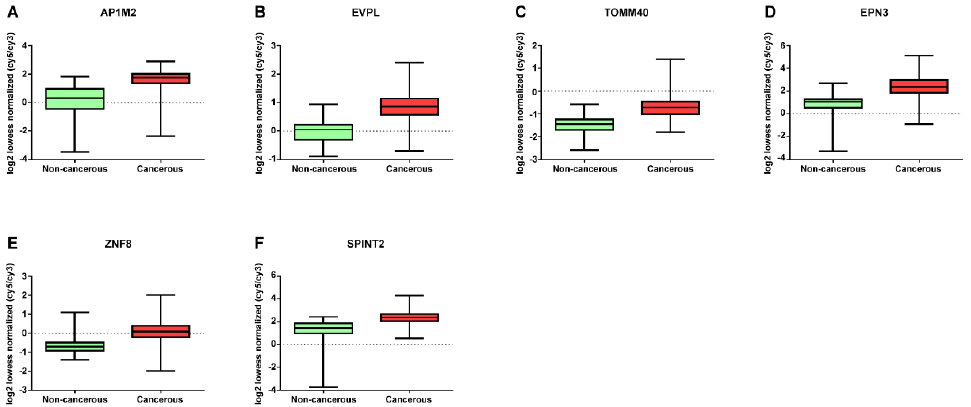
Figure 4. Expression levels of upregulated mRNA in non ‐ cancerous tissues. 6 DE mRNA profile data with p < 0.001 values. ( A ) AP1M2, ( B ) EVPL, ( C ) TOMM40, ( D ) EPN3, ( E ) ZNF8, and ( F ) SPINT2.